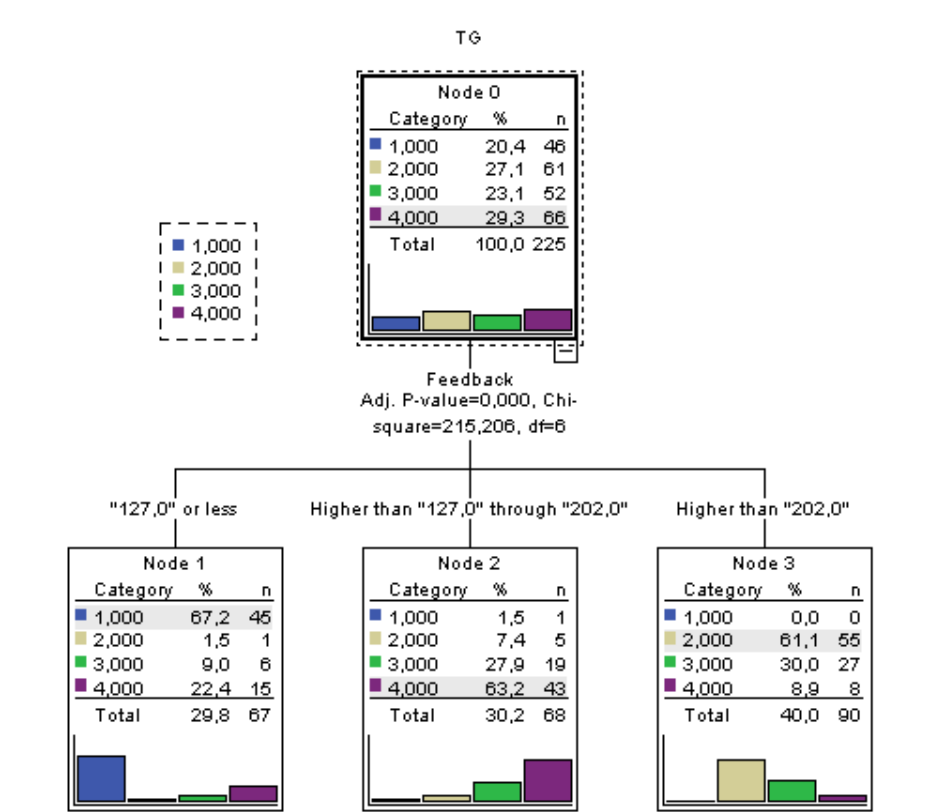
Figure 2. Decision tree on the effectiveness of combinations of ALT resources in LMS.